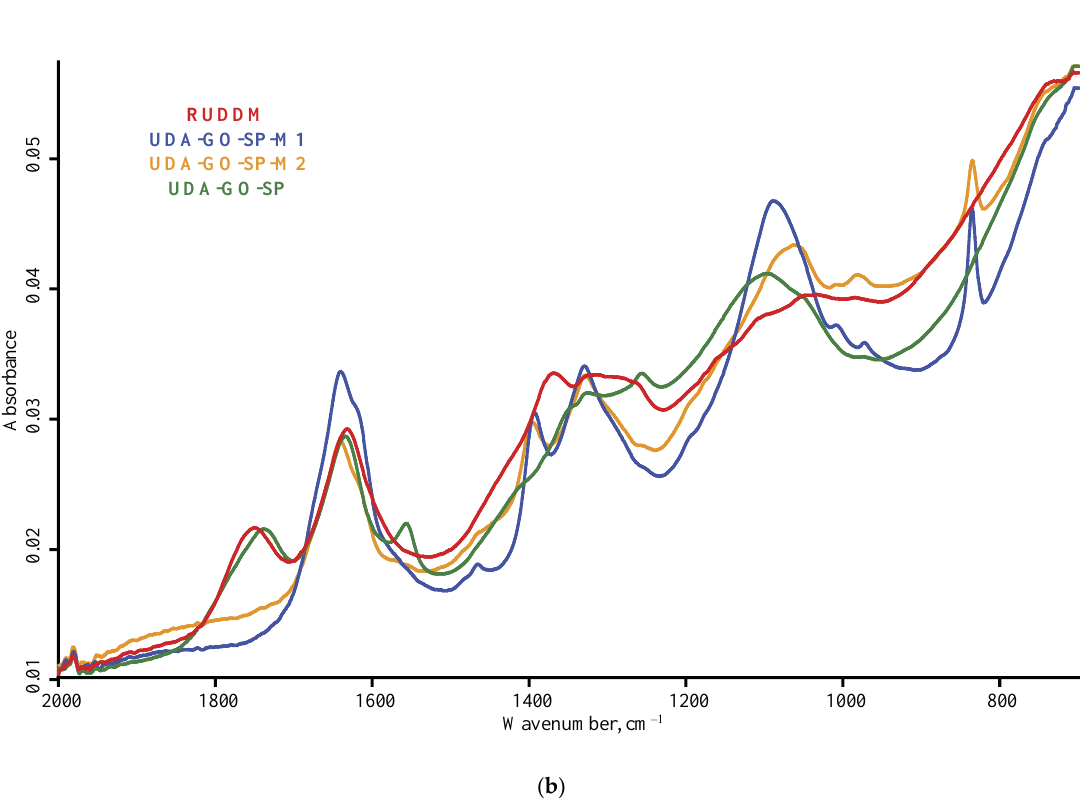
Figure A2. ATR mode, LN-MCT photovoltaic detector; nanodiamond brands: red, RUDDM; blue, UDA-GO-SP-M1; orange, UDA-GO-SP-M2; green, UDA-GO-SP; ( a ) 4000–2500 cm −1 , ( b ) 2000–400 cm −1 range. Spectra were smoothed (13 points) and normalized to maximize each spectrum.